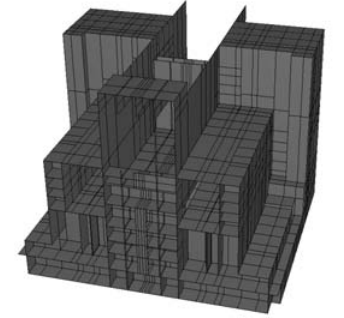
Fig. 3. Model: East-West cross-section (y = 90,0 m) The scheme of connection of mass of the removed structures of the building to the model walls is in Fig. 4.